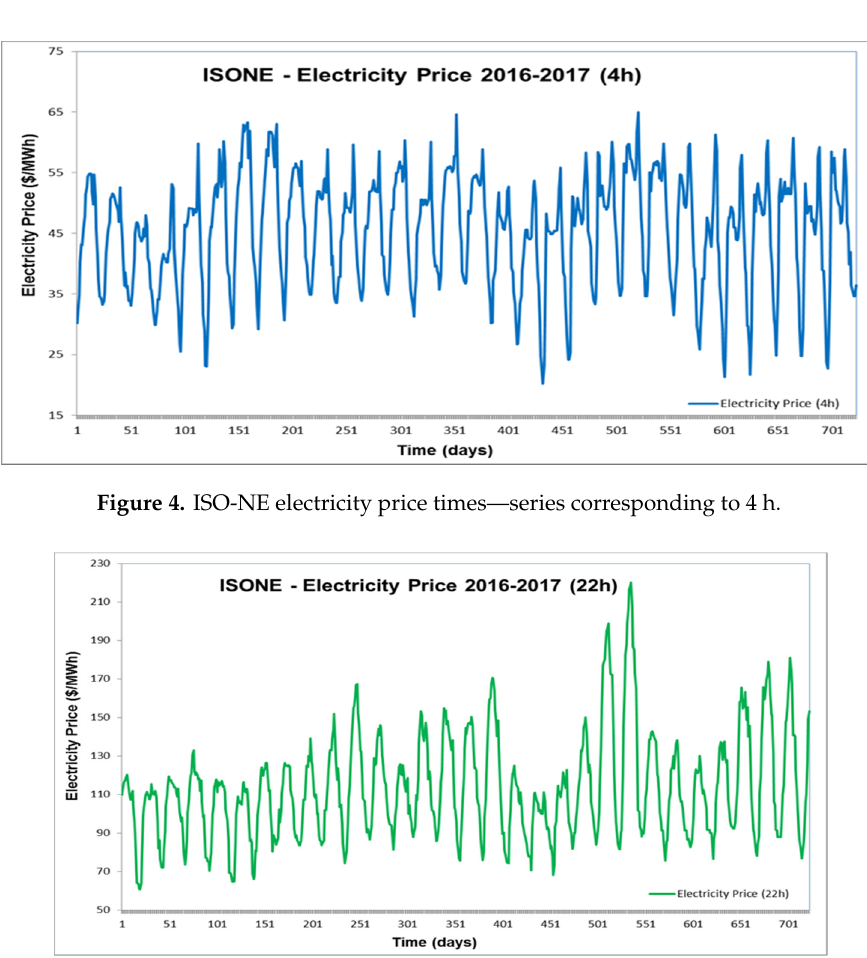
Figure 5. ISO-NE electricity price times—series corresponding to 22